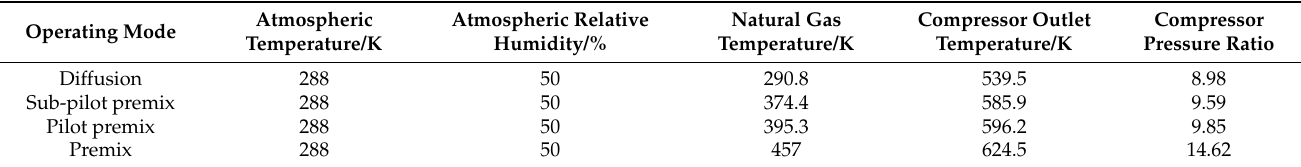
Table 5. Combustor inlet boundary conditions.